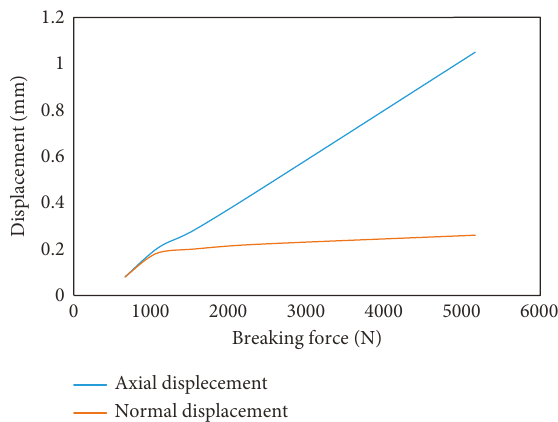
Figure 16: Axial and normal displacements as a function of breaking